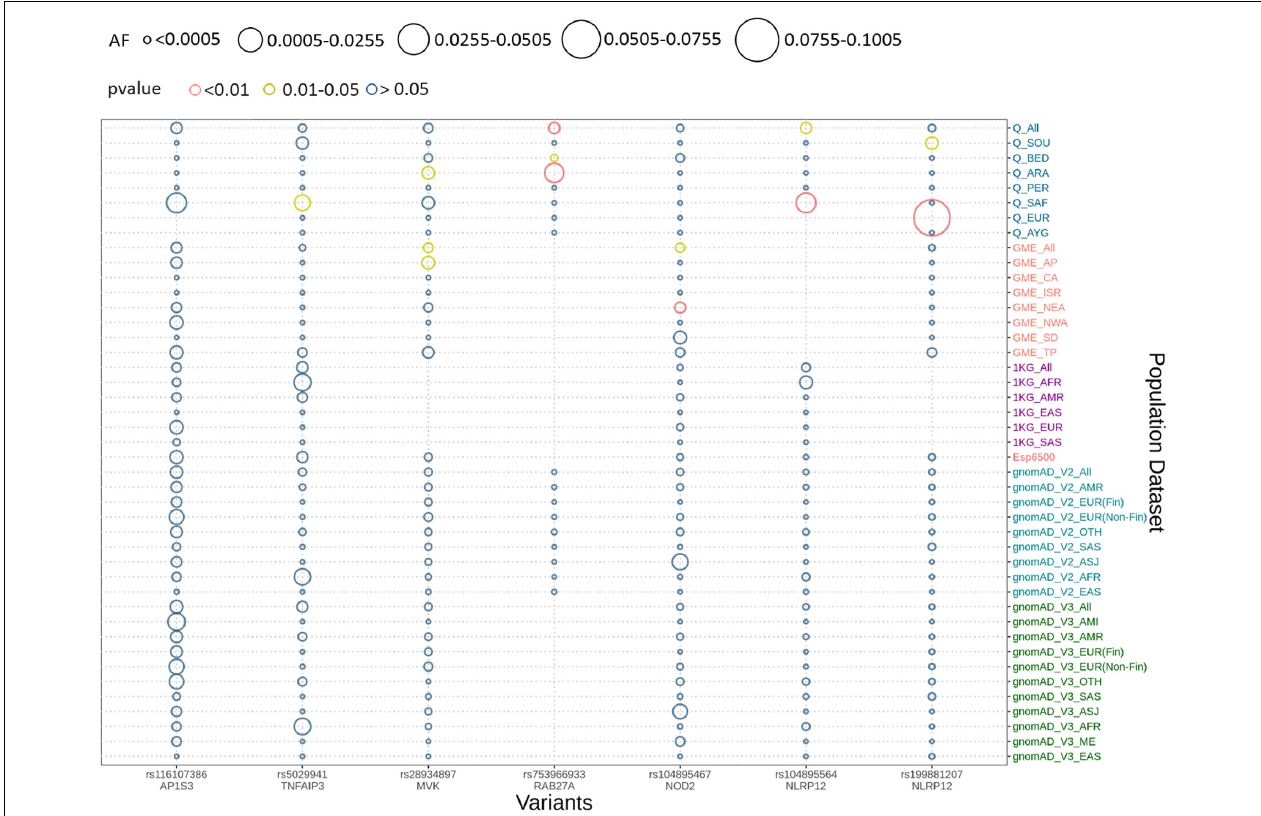
FIGURE 2 | Comparison of allele frequency of pathogenic and likely pathogenic variants in the Qatar population with its subpopulation and GME and its subpopulation with 1000 genome, Esp6500, gnomAD V2, and gnomAD V3 and their subpopulations. Allele frequency highlighted with red for the p -values < 0.01, yellow for p -value between 0.01 and 0.05 and blue for p -value >